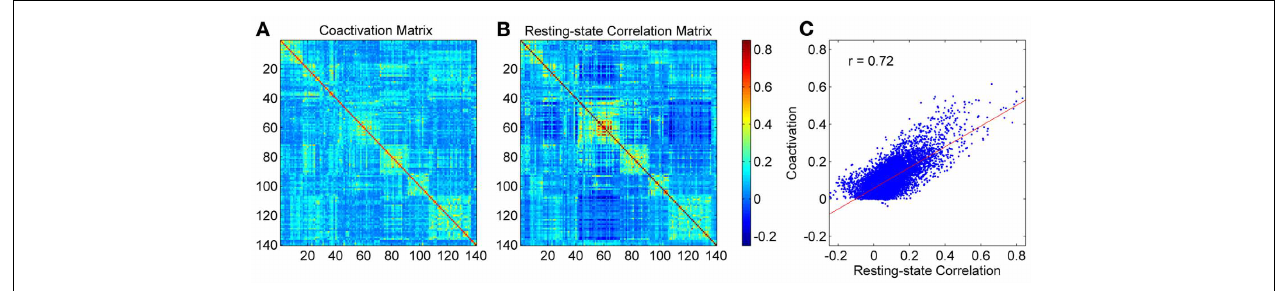
FIGURE 1 | Coactivation matrix (A), resting-state correlation matrix (B), and the relationship between coactivation strengths and resting-state correlations (C). Each dot in the scatter plot represents one pair of ROIs. The red line in panel (C) represents the linear